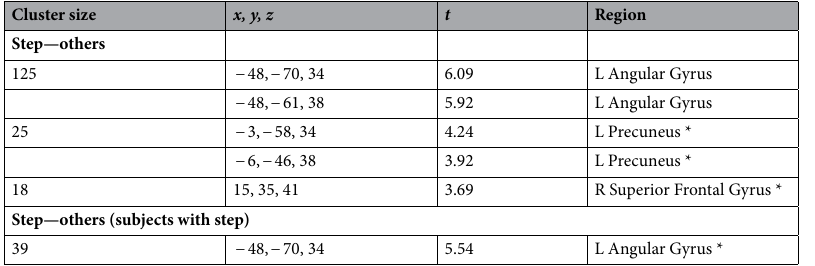
own-voice. This variability may be due to the task demands; self-recognition by own-face or own-voice stimuli requires a relatively larger cognitive load than other kinds of stimulus processing. Self-recognition tasks have